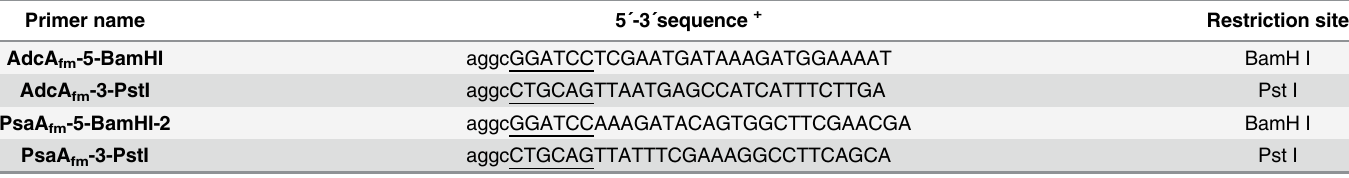
Table 2. Primers used in this